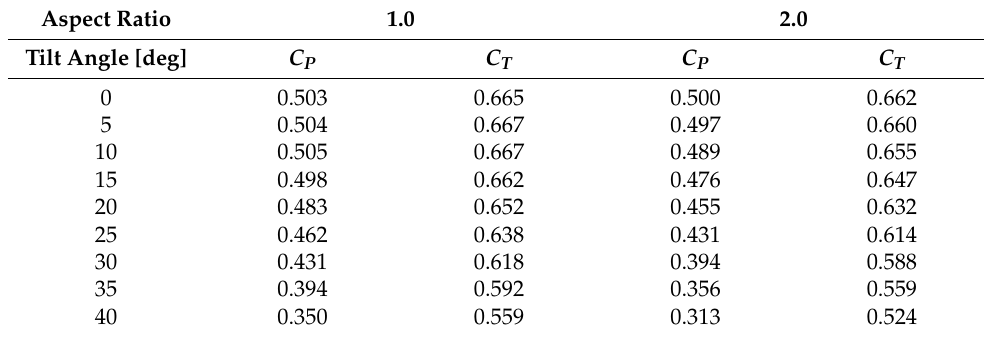
Table 4. Power and Thrust coefficients with respect to tilted angle.